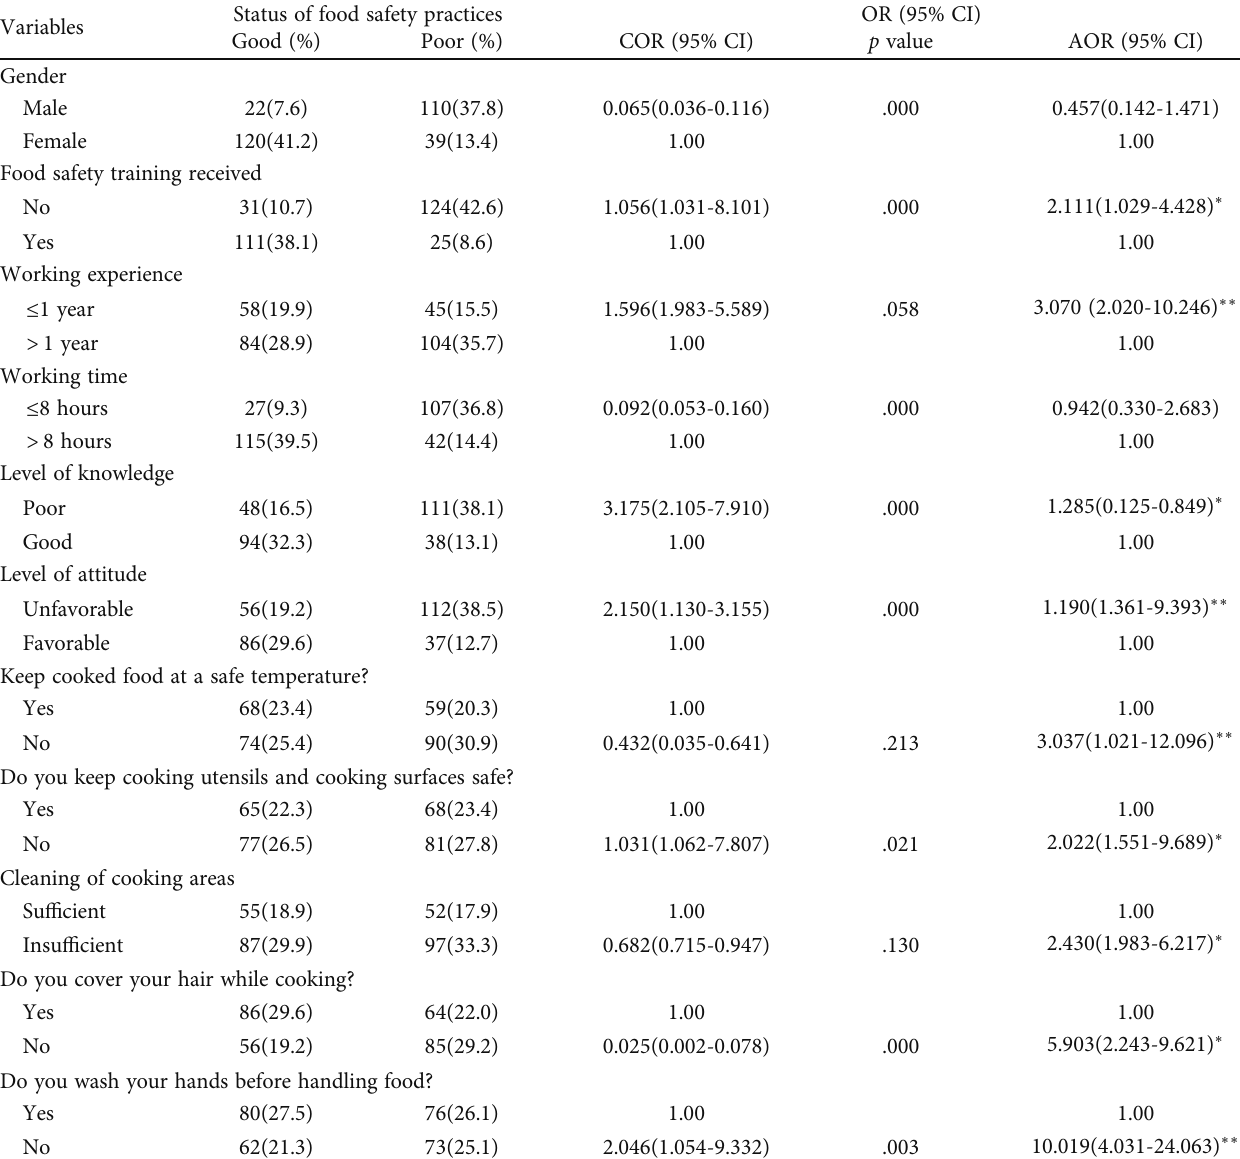
Table 4: Bivariate and multivariate analysis of factors related to food safety practices among food workers working in the student canteen at the University of Woldia, May-July 2021, ( n = 291